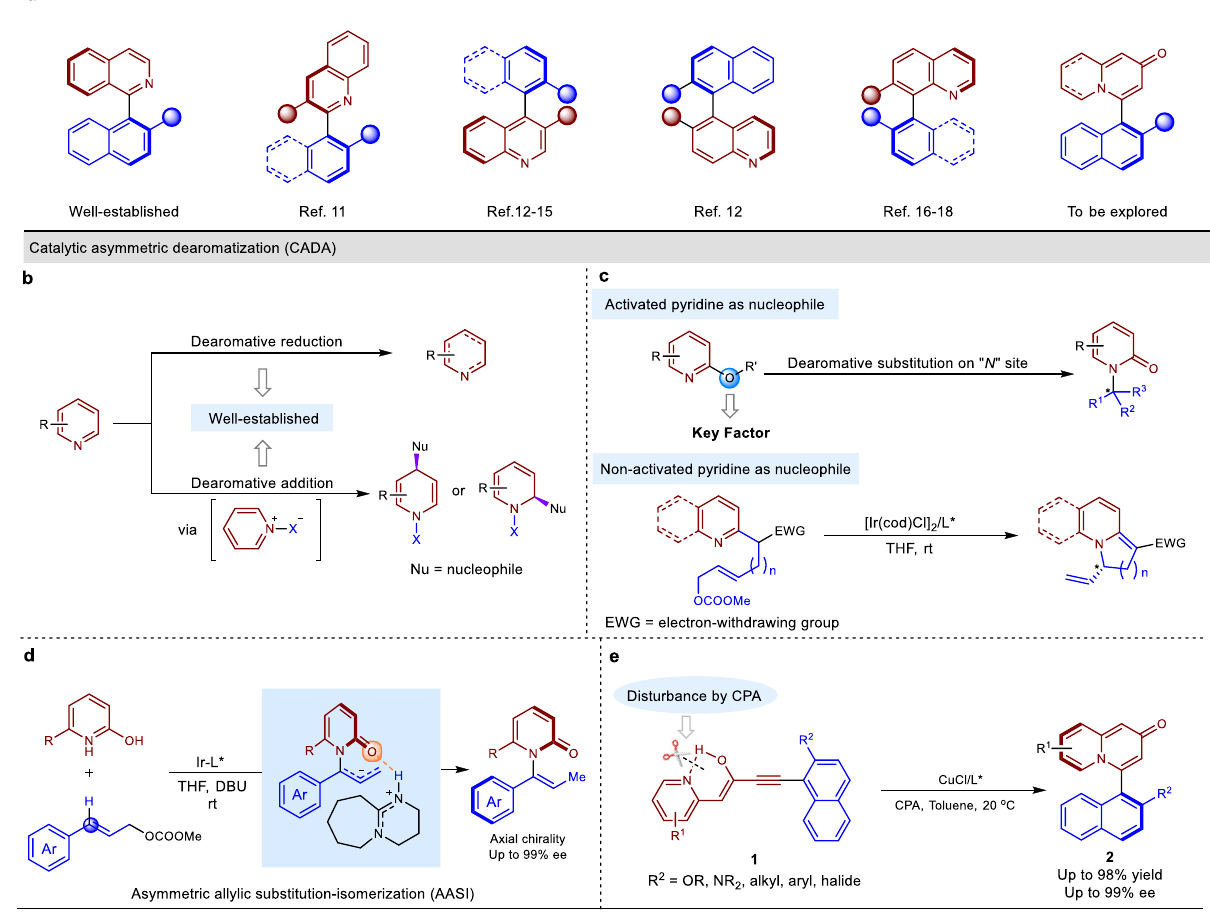
Fig. 1 Background and concept design. a Representative examples of axially chiral axially chiral N -heterobiaryls. b State of the art of CADA using pyridine as an electrophile. c State of the art of CADA using pyridine as a nucleophile. d AASI for the synthesis of axially chiral enamides. e Atroposelective cycloisomerization to axially chiral